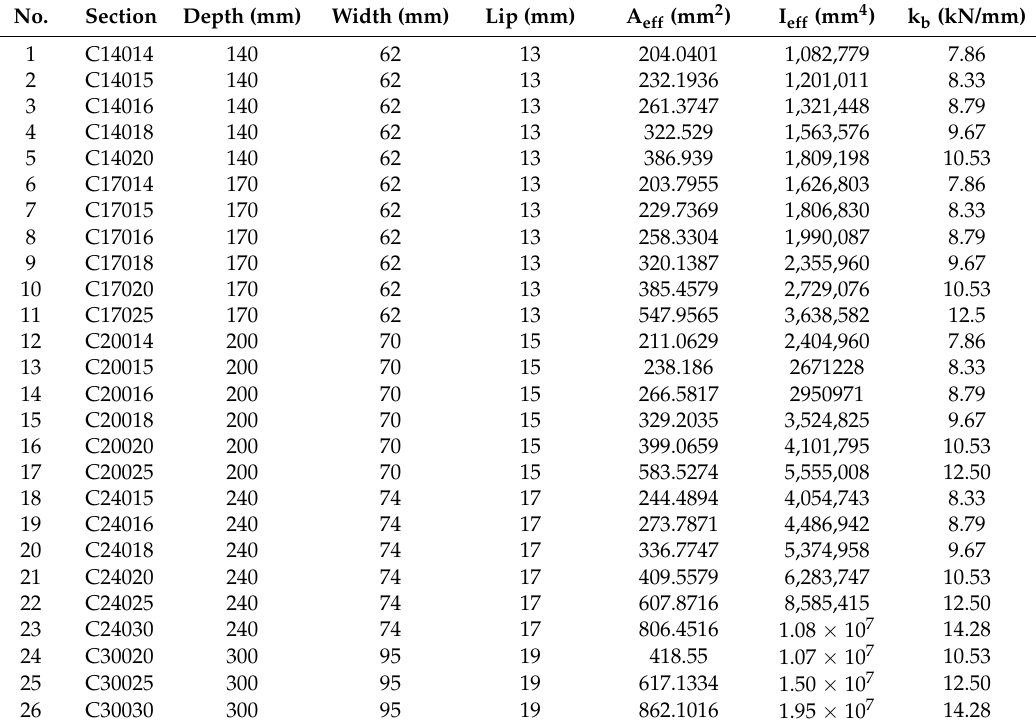
Table 1. The list of CFS channel sections used for frame